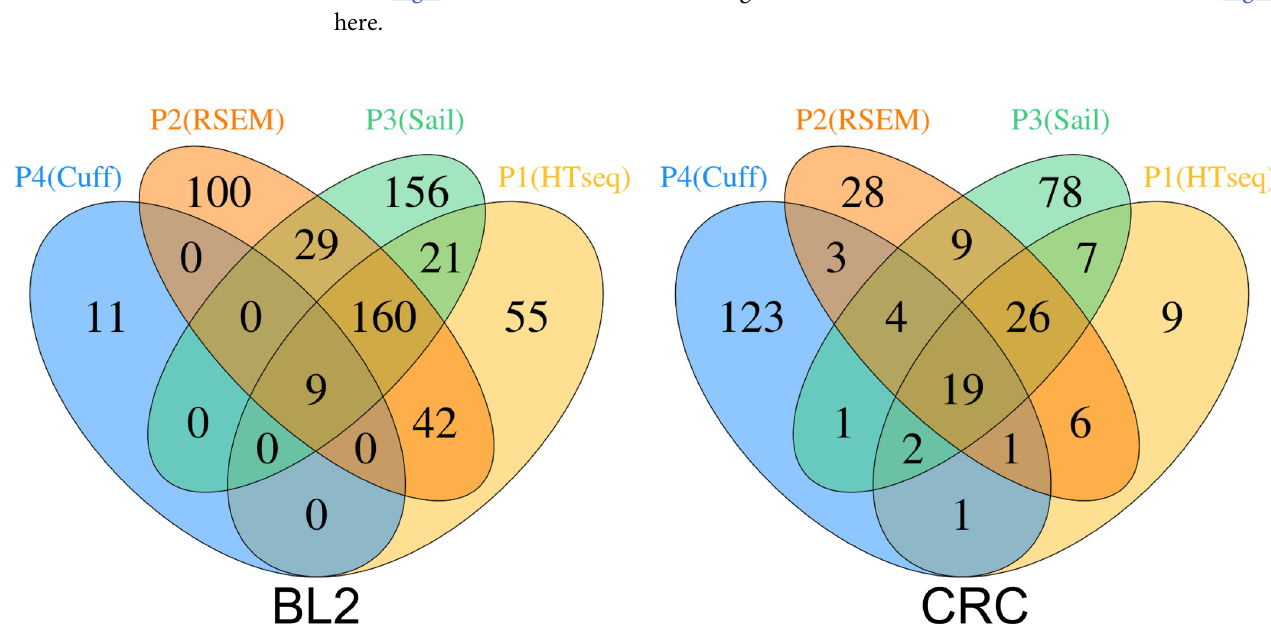
‘Consensus’ stands for the amount of genes shared with at least two other Pipelines and ‘unique’ for genes not found by any other Pipeline from the total amount of genes found by each